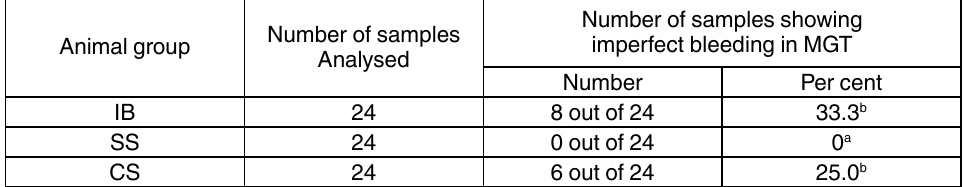
Table 2. Proportion of samples from IB, SS and CS carcasses showing imperfect bleeding in malachite green test Animal group